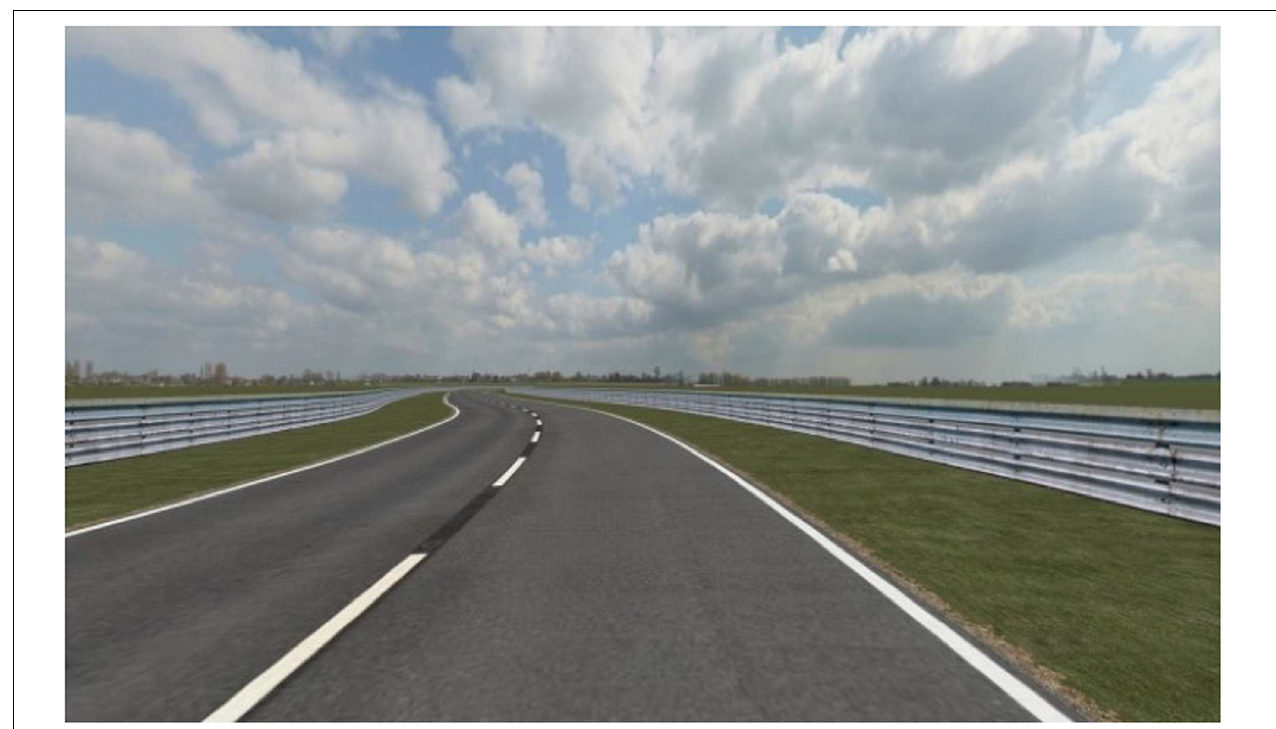
FIGURE 2 | Screenshot of the driving scene consisting of a two lane roadway with guardrails on either side and agricultural scenery on the